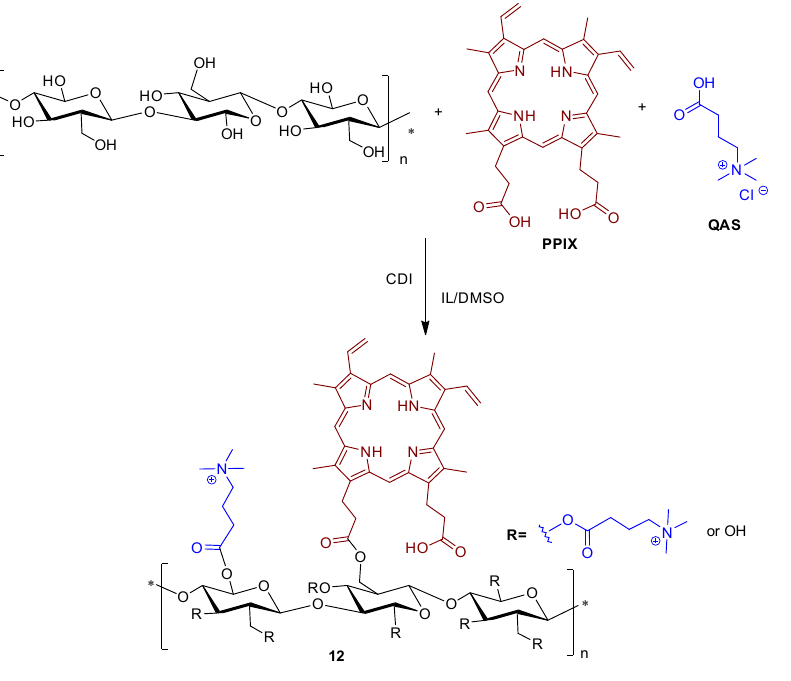
Figure 8. Strategy for preparation of water-soluble hybrid photoactive material 12 containing PPIX and QAS groups onto a cellulose support (adapted from Ref. [69] ).